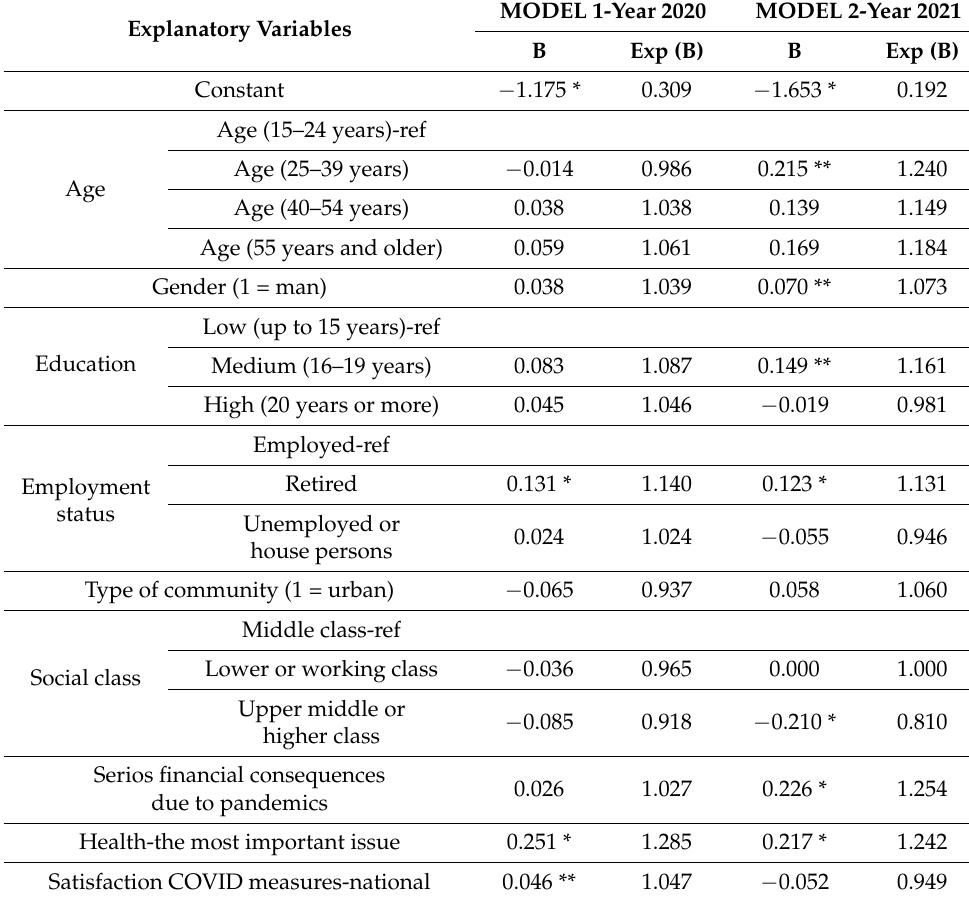
Table 3. The results of the logistic regression. Explanatory